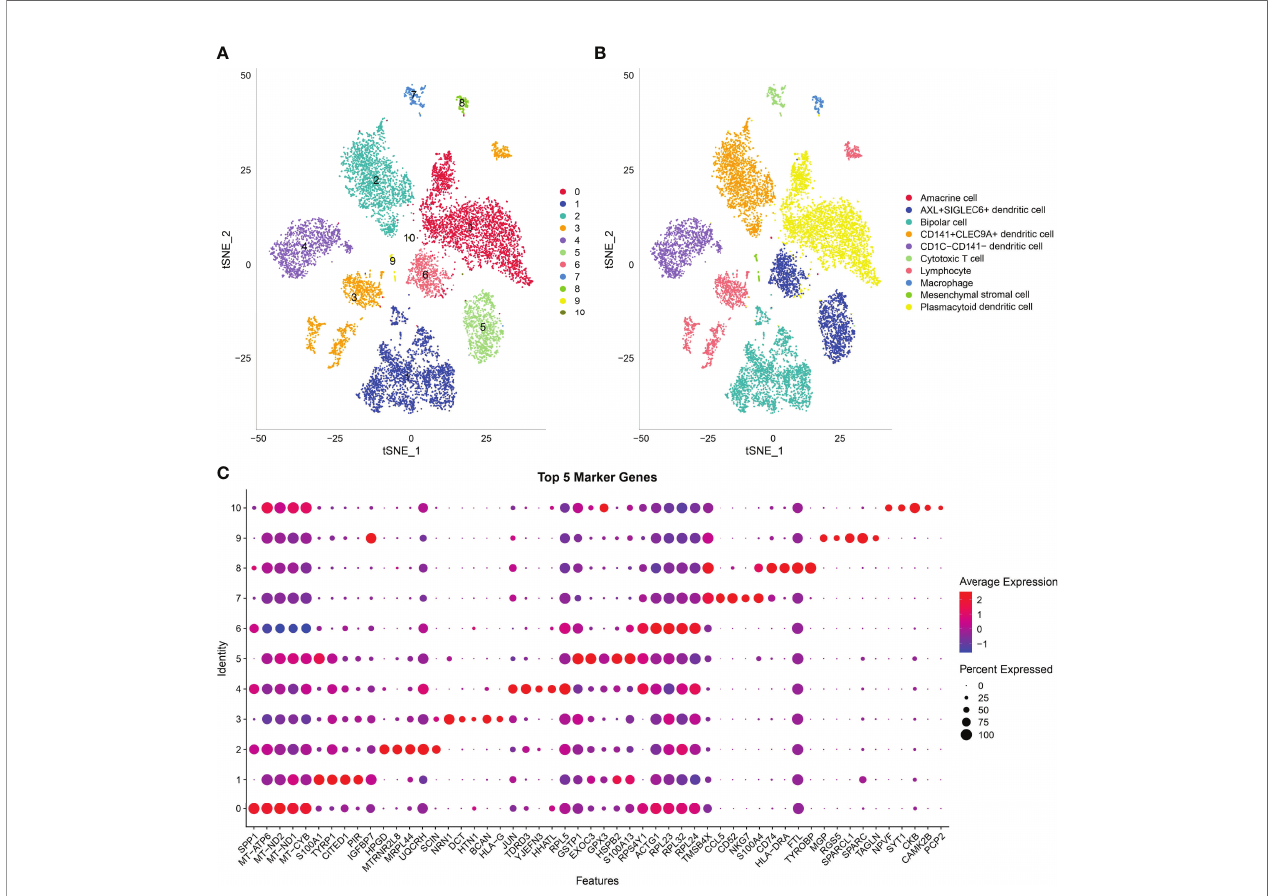
FIGURE 3 | Analysis of scRNA-seq data in UM revealed 11 cell clusters annotated to different cell types. (A) The t-SNE map of all cells after quality control and standardization revealed 11 cell clusters marked with different colors. (B) 11 cell clusters according to gene marker annotated cell types. (C) The bubble diagram shows the expression of the top fi ve marker genes in different cell